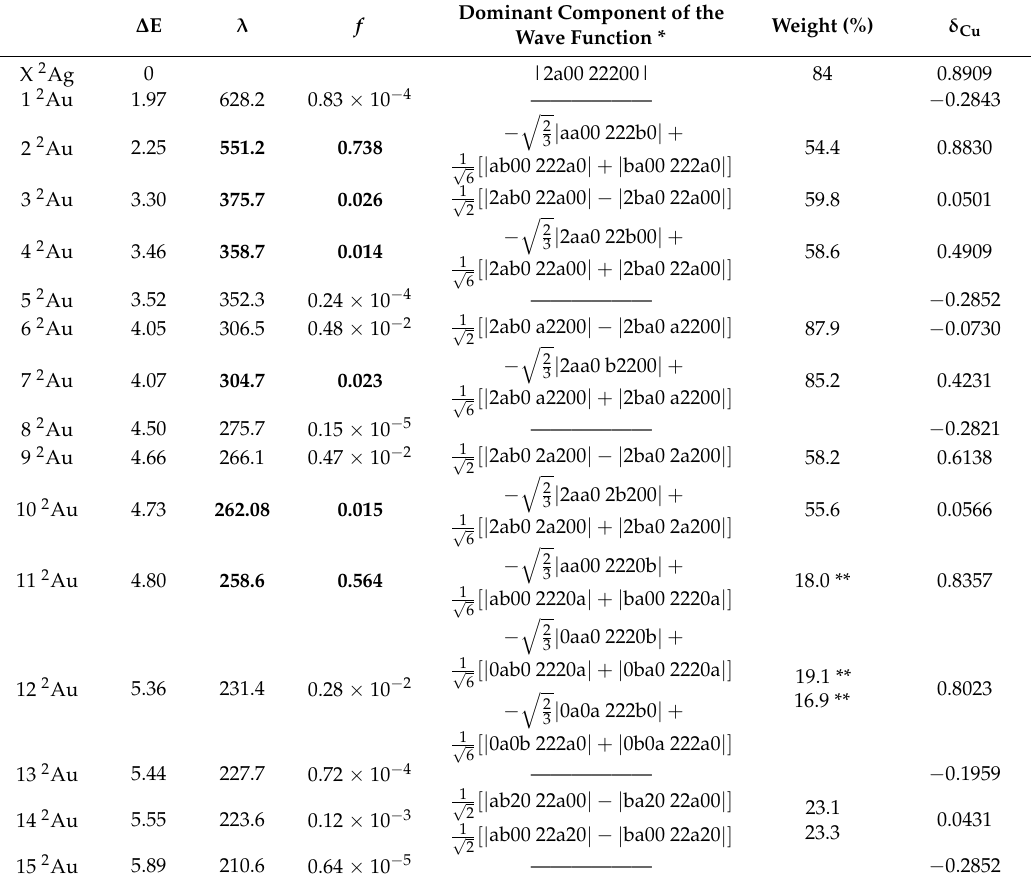
Table 1. Lowest excited Au states accessible by UV irradiation. Relative MS-CASPT2 energy (eV), wavelength (nm), oscillator strength ( f ), dominant component of the wave function, and Mulliken spin density on Cu atom ( δ Cu ) evaluated from the natural MOs for each root. ∆ E λ f Dominant Component of the Weight (%) δ Wave Function *